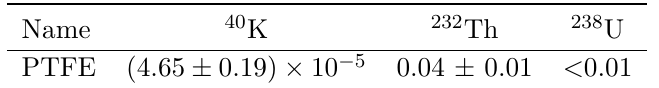
Table 9. NAA measurement of PTFE for PandaX-4T (unit: